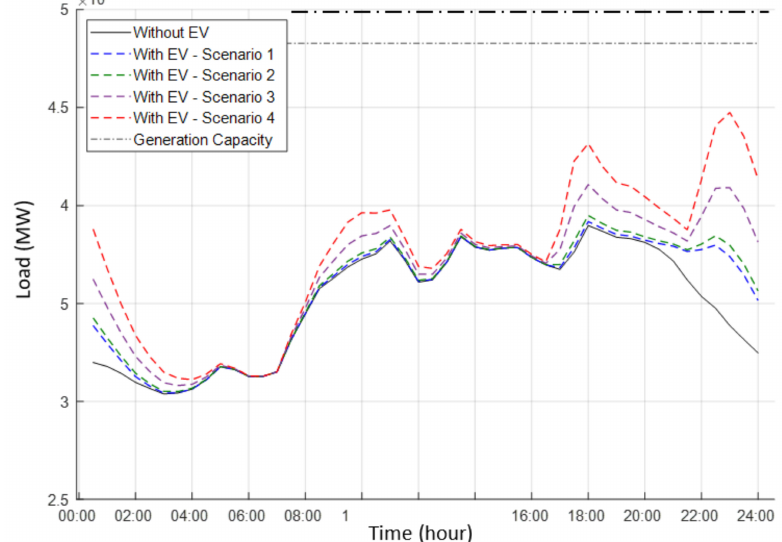
Figure 5. Java-Bali forecasted load profile with various EV integration scenarios with a fixed scheduling